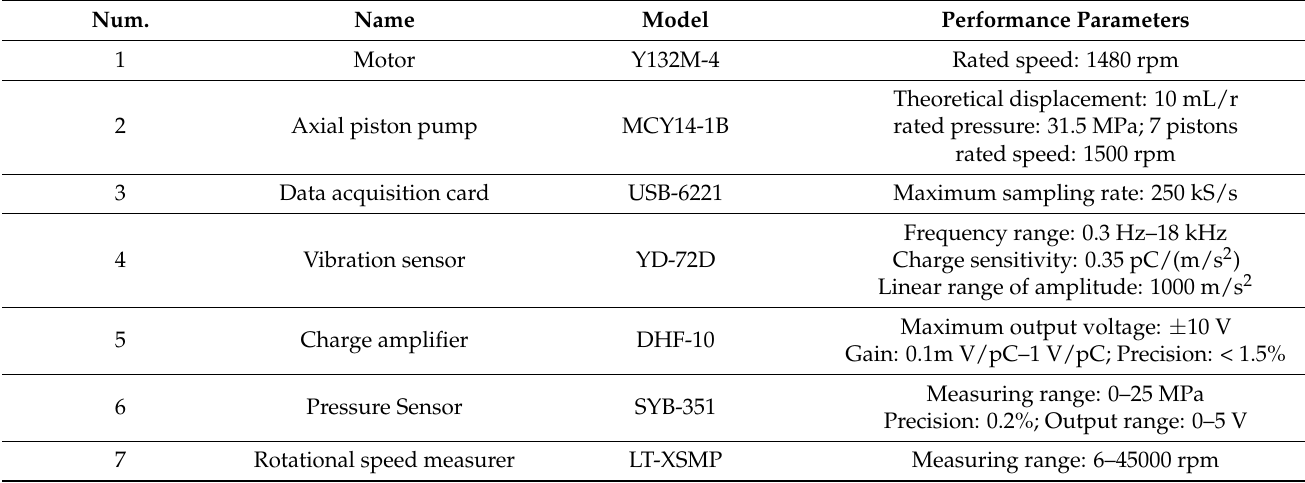
Table 1. Types and performance parameters of test components.